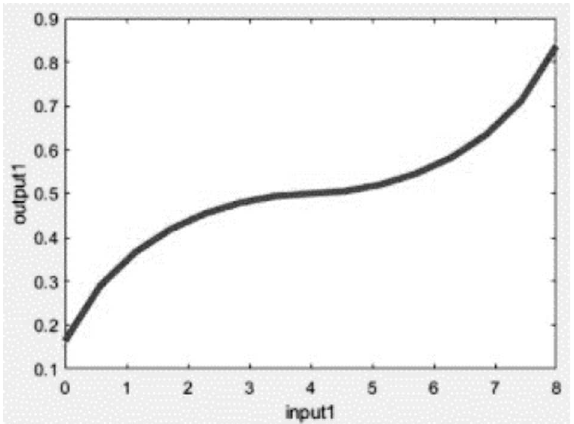
Analysis of Selected Learning